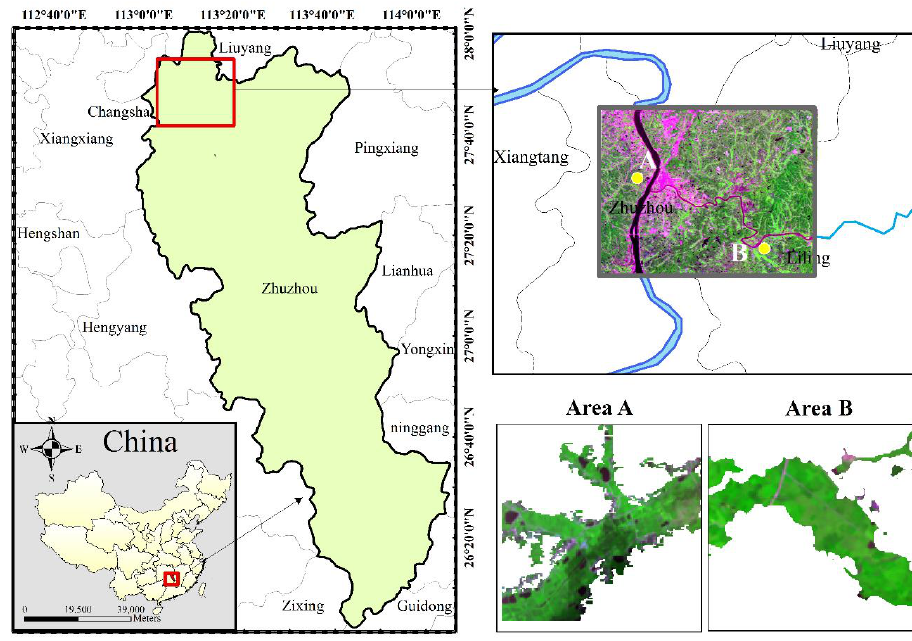
Figure 1. Location of the study area and the GF-1 image used in this study. GF-1 image parameters (RGB = G (0.52–0.59 μm), NIR (0.77–0.89 μm), and R (0.63–0.69 μm)) of the study areas in Zhuzhou, Hunan Province, China.